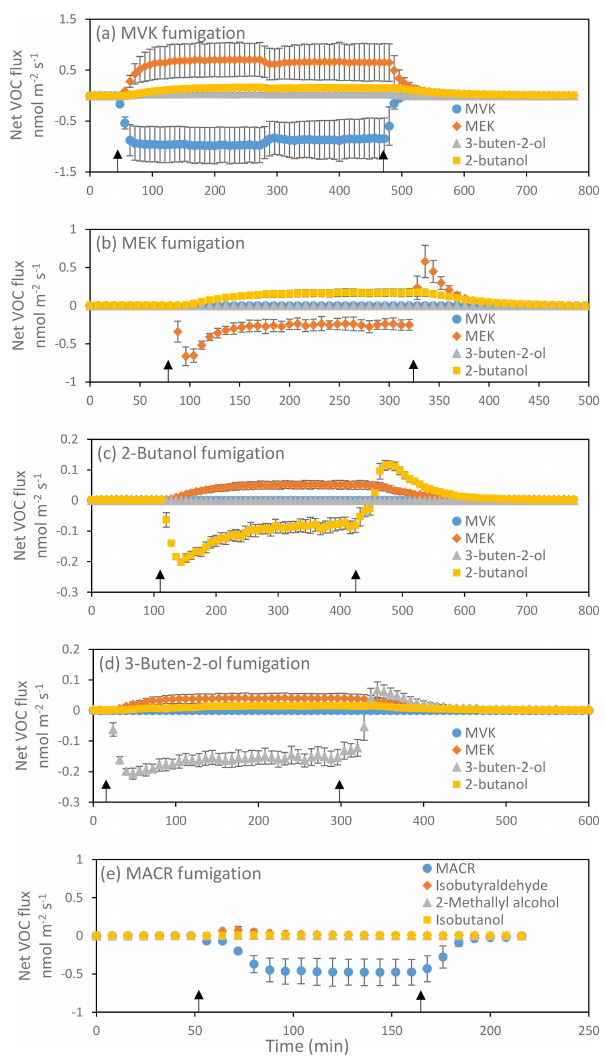
Figure 1. Uptake of MVK (a) , MEK (b) , 2-butanol (c) , 3-buten- e-ol (d) and MACR (e) and emission of their oxidized or reduced products in red oak leaves. Results are reported as mean ± standard deviation ( n = 3). Negative values denote the uptake and positive values the emission of volatiles. Black arrows indicate the begin- ning and the end of the fumigation. In (b) , the pulses of MEK up- take at the beginning of the fumigation and of MEK release after the end of the fumigation correspond to formation and release, respec- tively, of a MEK pool dissolved into the leaf water. At equilibrium the uptake of MEK and subsequent release of 2-butanol is constant and indicates a constant rate of MEK transformation within leaves. Analogous considerations can be made for 2-butanol and 3-buten- 2-ol in (c) and (d) ,